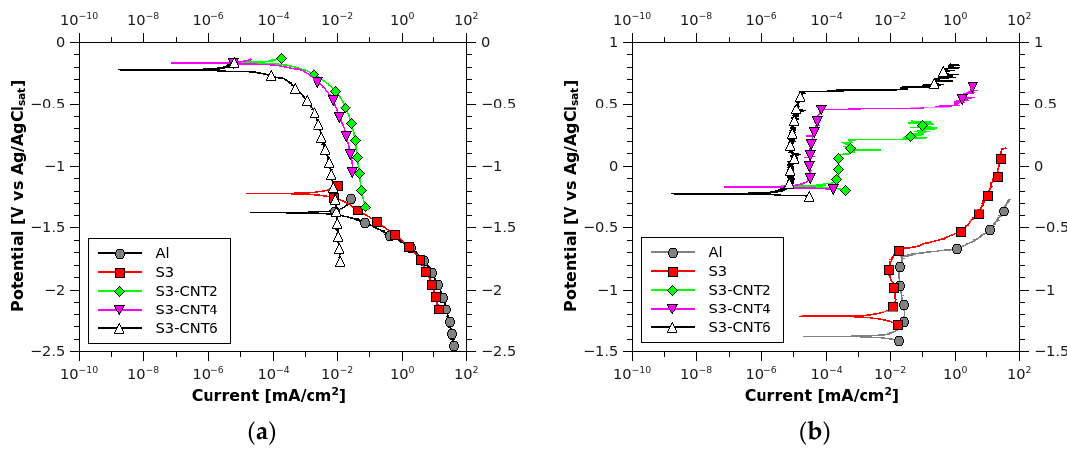
Figure 6. Potentiodynamic polarization curves in NaCl 3.5 wt.% solution for CNT silane coating for ( a ) cathodic branch ( b ) anodic branch. Bare aluminum and pure silane coating were also added as references.